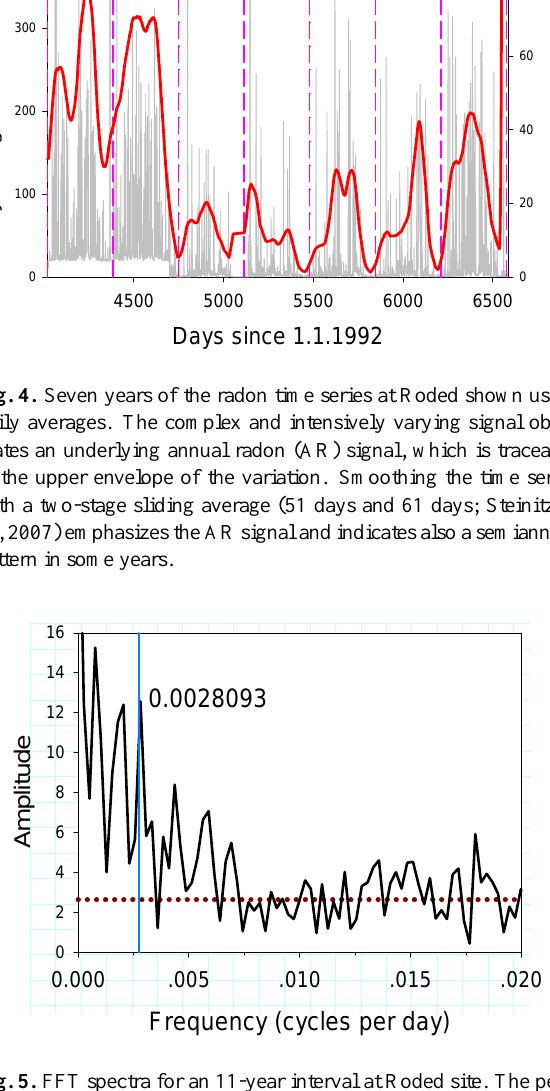
Figure 6: Times of very low background alternate with days with intense SDR signals. SDR signals occur in some days (Left). Multi days (MD) signals are formed by groups of SDR signals occurring on consecutive days (Right).